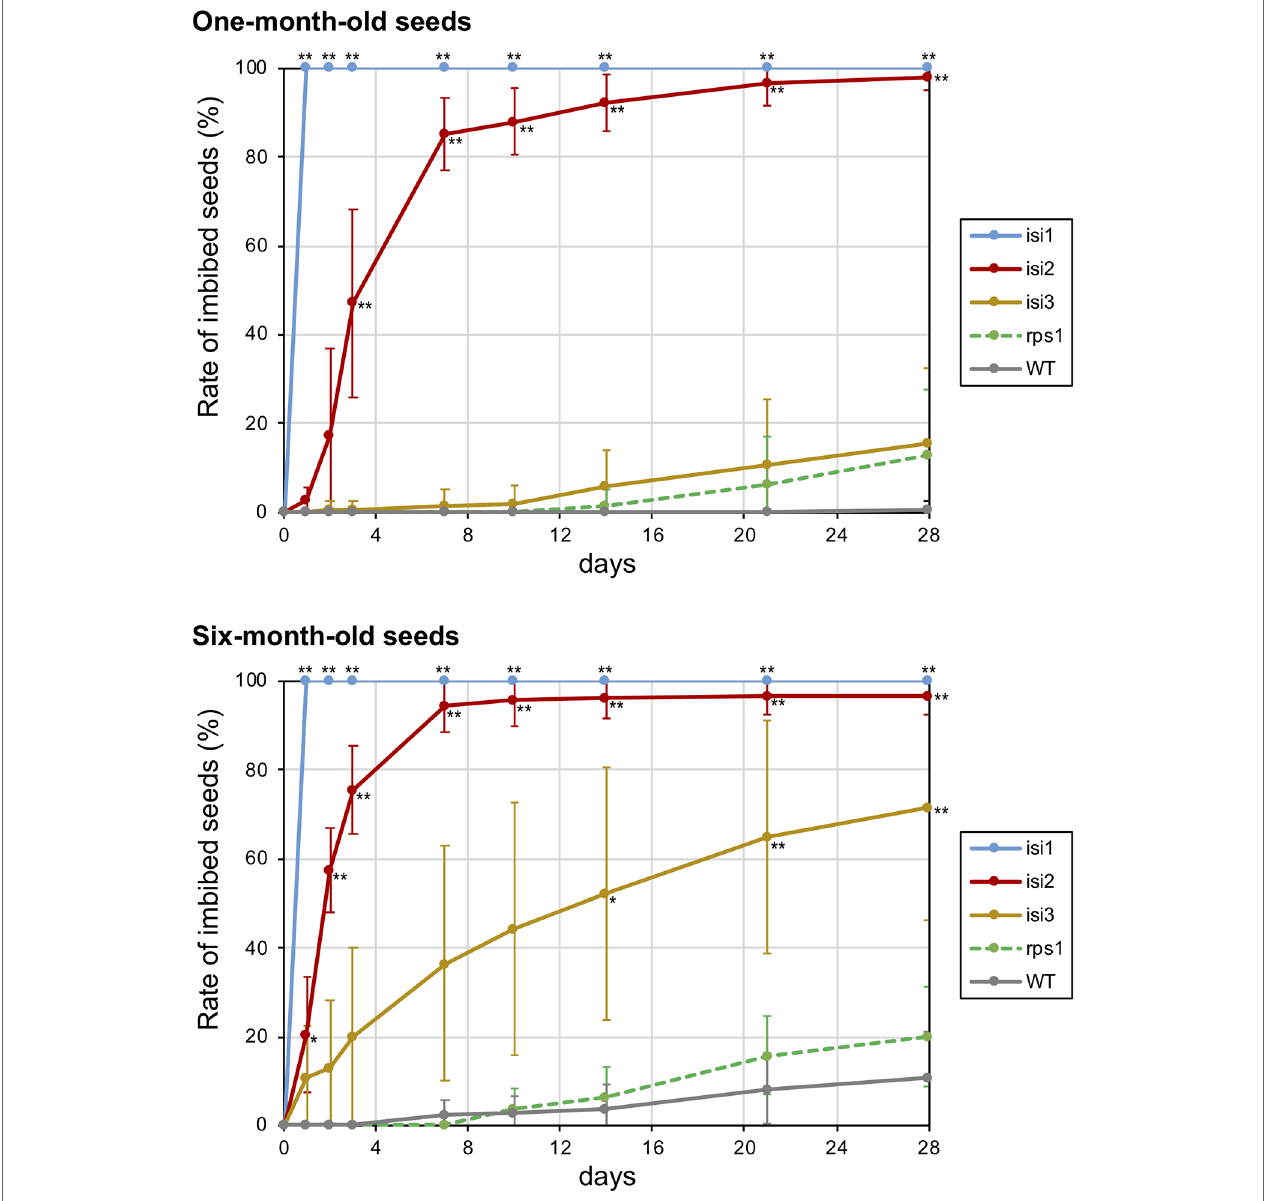
FIgURe 6 | Rate of imbibed seeds in the mutant plants over time. Twenty seeds of 1 and 6 months old were soaked in distilled water and number of imbibed seeds were manually counted twice a week for 4 weeks. The error bars indicate standard deviation of replicated evaluations (n = 7). Asterisks indicate that the mean values are significantly different from the wild type (** for p < 0.01 and * for p < 0.05).